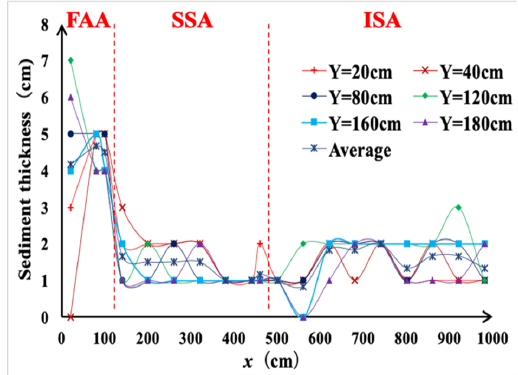
Figure 7. Sediment thickness of different sections at the bottom of the tank.